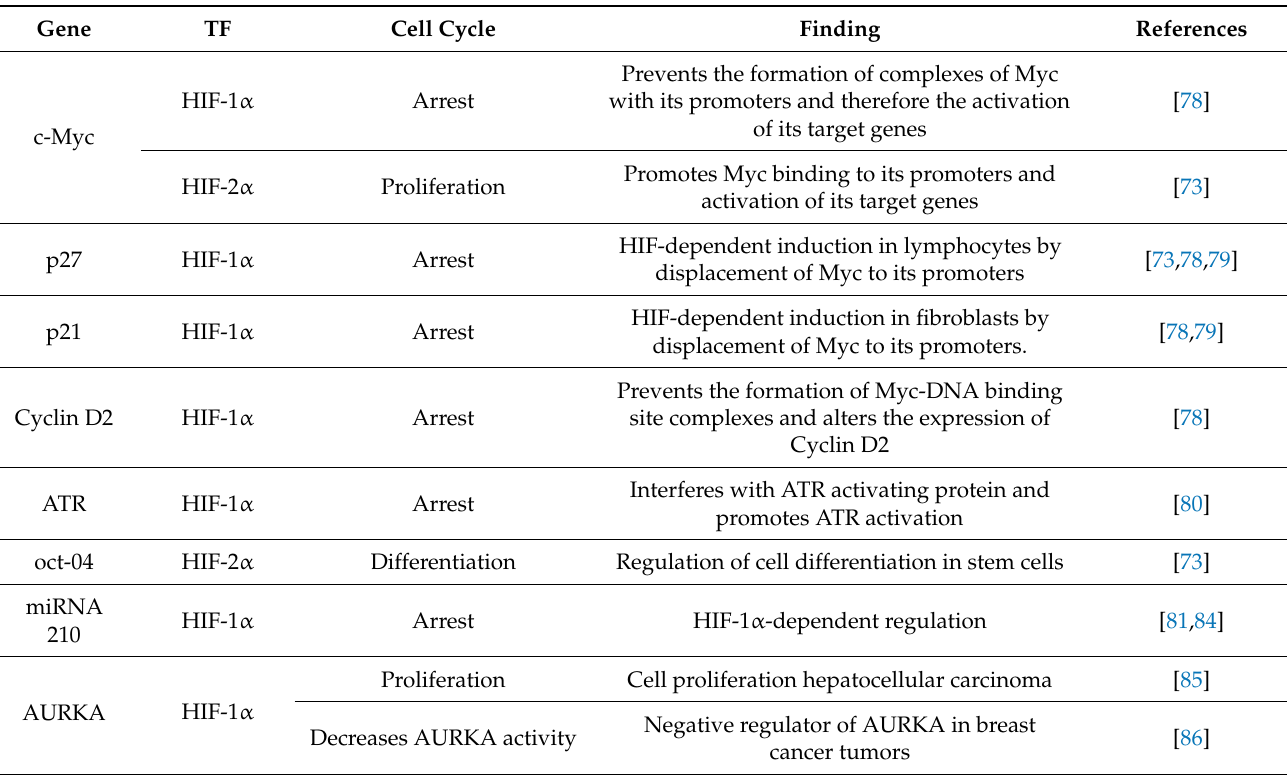
Table 1. Effect of HIF-1 α and HIF-2 α on the cell